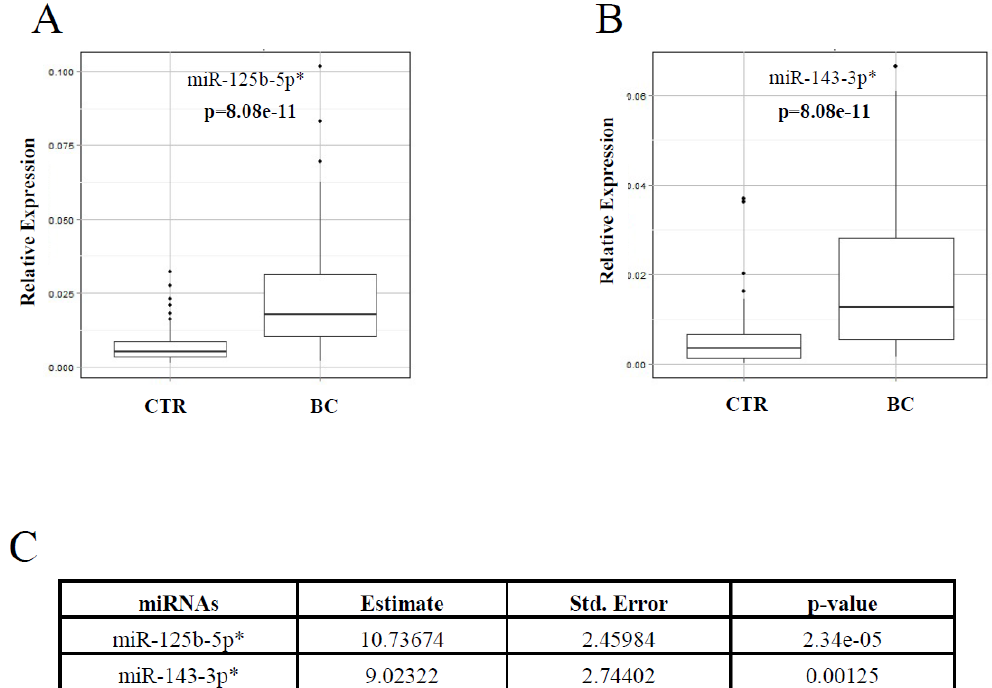
Figure 2. Validation II. Relative expression of miRNAs selected in a study population of 78 healthy donors (CTR) and 77 breast cancer (BC) subjects. Box plot analyses performed to show the relative expression of miR-125b-5p ( A ) and miR-143-3p ( B ) in the plasma samples of healthy donors vs. BC patients. Logistic stepwise regression analysis ( C ). * miRNAs that significantly ( p < 0.05) estimate the probability of having BC.